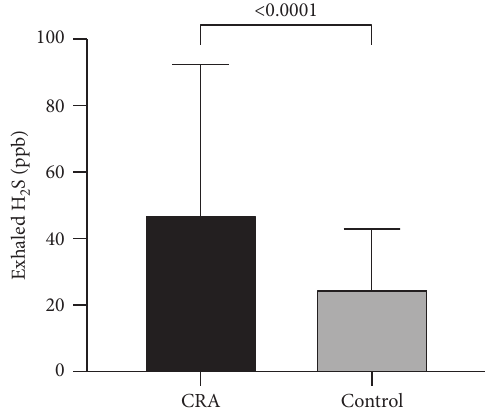
Figure 2: Exhaled H 2 S comparison between two groups.